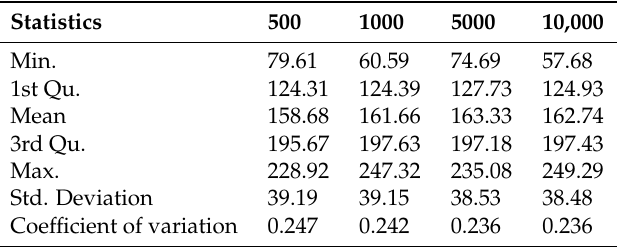
Table 4. Statistical summary of the samples (500, 1000, 5000, and 10,000 iterations) generated via MCMC using the Kernel method.